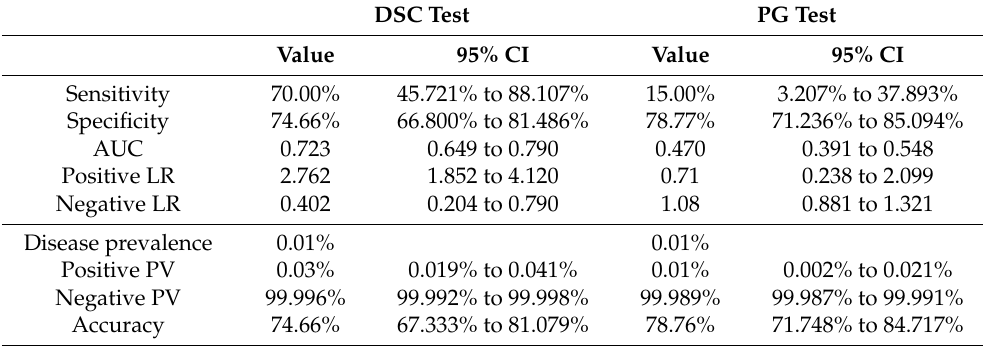
Table 6. Comparison between the predictive values of the DSC test and pepsinogen tests for GC